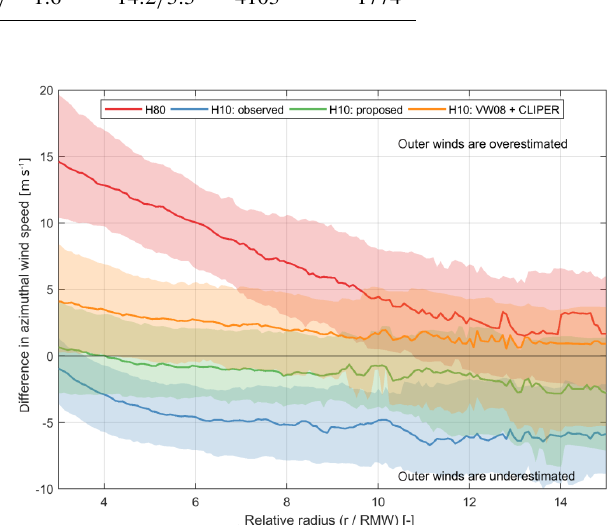
Figure 7. Wind speed error (observed QSCAT-R minus mod- eled) profiles for different models as a function of relative TC ra- dius ( r/ RMW). A value equal to zero on the y axis indicates a per- fect match between model and observations. Interquartile ranges are shown with shaded colors and the solid line represents the median. Note: for the proposed relationships the most probable value for RMW and AR35 was used (i.e.,